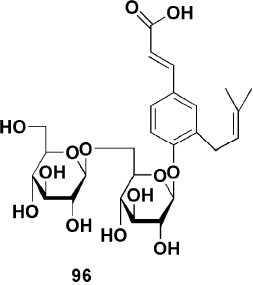
Figure 25. Chemical structure of dissectumoside, 96 [67].